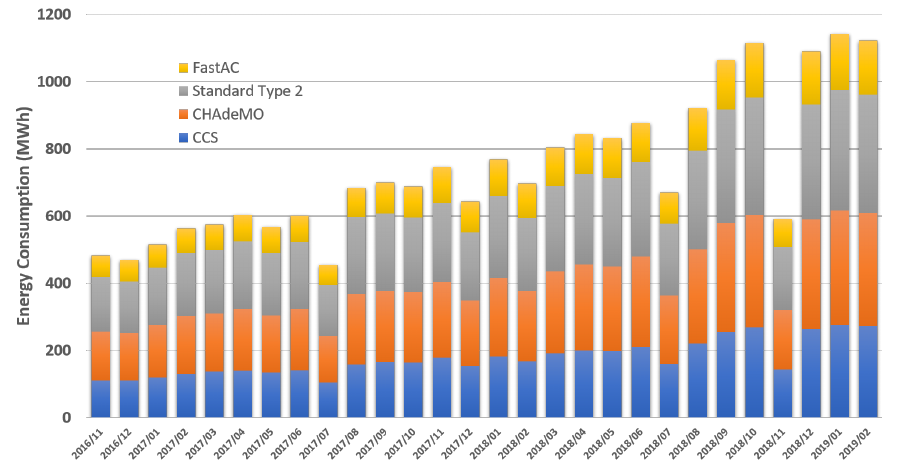
Figure 11. Monthly energy consumption for the EV infrastructure, divided by type of charging station.